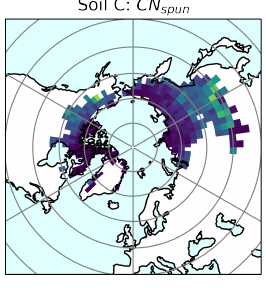
Figure A4. Spatial distribution of soil carbon in kg m − 2 for the top 3 m of the soil and the three different versions of JULES CN spun , CN 1.5 spun , and CN 2 spun . Additionally shown are the NCSCD observed soil carbon data for the top 3 m [49].